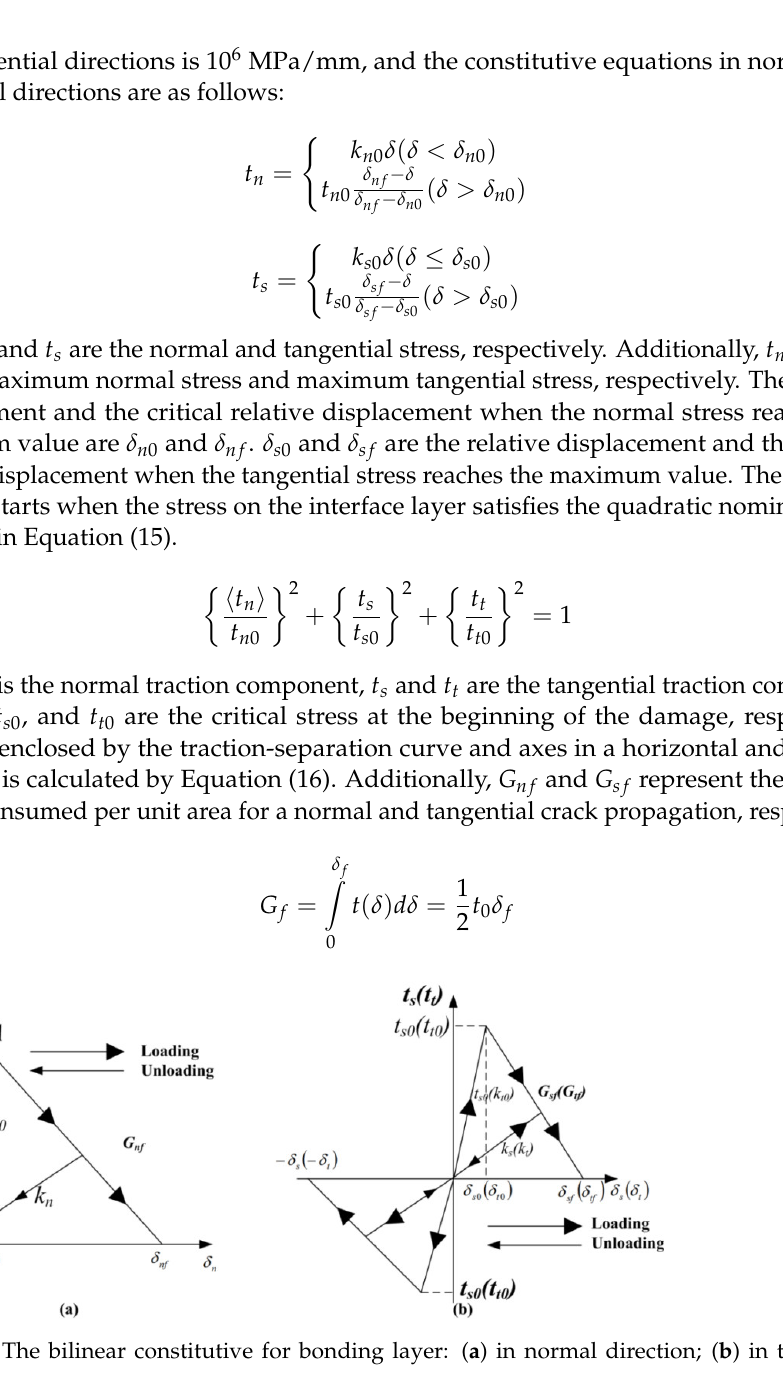
Figure 4. The bilinear constitutive for bonding layer: ( a ) in normal direction; ( b ) in tangential direction.